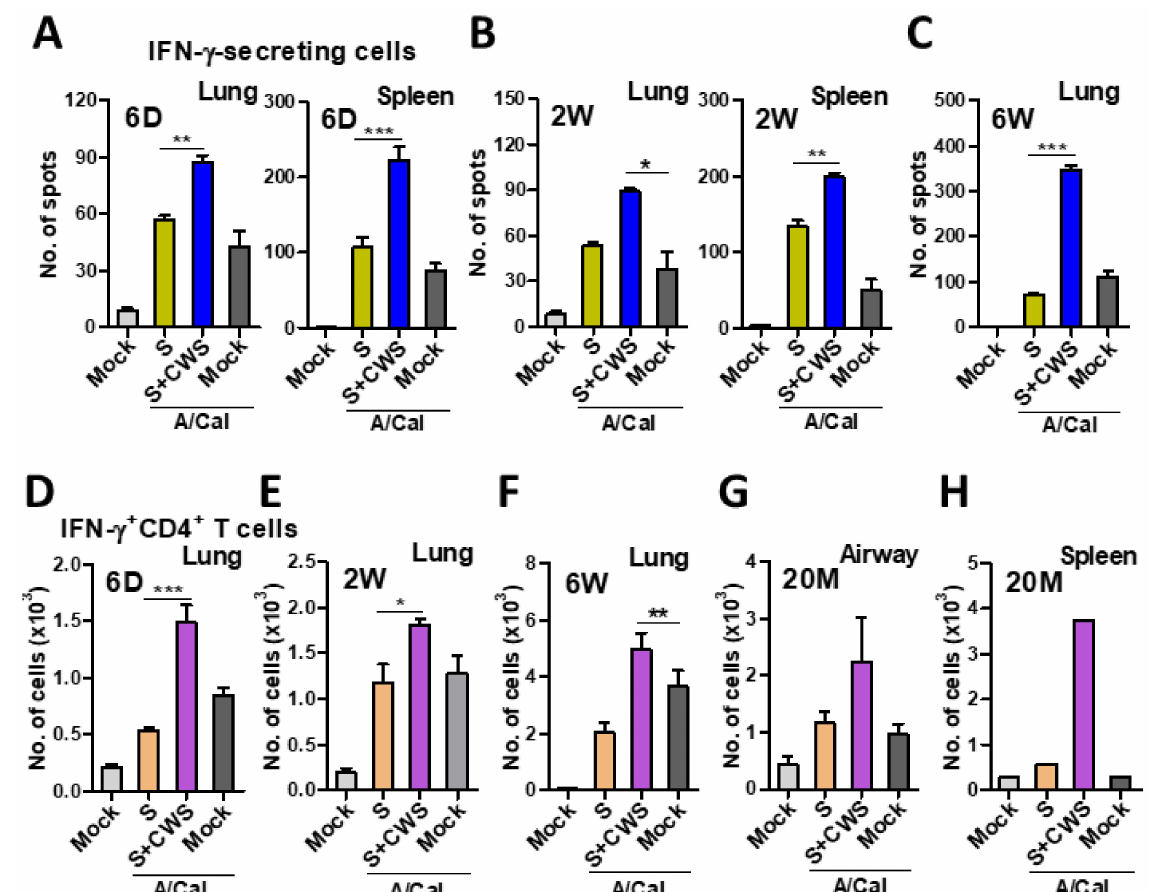
Figure 7. IFN- γ secreting cellular responses in lung and spleens at early time after challenge. IFN- γ secreting cells were determined in lung and spleen samples collected from the 6 D, 2 W, 6 W, and 20 M groups at 7 dpi with A/Cal virus challenge. ( A – C ) Virus antigen-specific IFN- γ secreting cells in the lung or splenocytes from the different age vaccinated groups as determined by ELISpot assay. ( D – H ) The IFN- γ -secreting CD4 + T cells (IFN- γ + CD4 + T cells) in the lung, airway (BAL), or spleens from the different age vaccinated groups as determined by intracellular cytokine staining and analyzed by flow cytometry. Statistical significance was calculated by using one-way ANOVA and a Dunnett’s multiple-comparison test. Data are presented from all animals. Error bars indicate the mean ± SEM. *; p < 0.05, **; p < 0.01, ***; p <